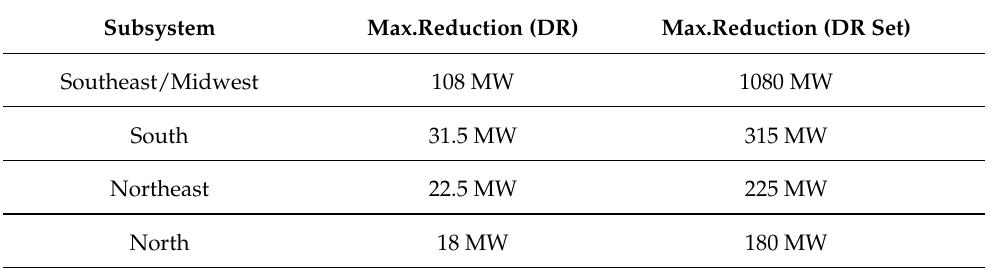
Table 2. Maximum reduction limits to DR set per subsystem—reduction limits per aggregation.